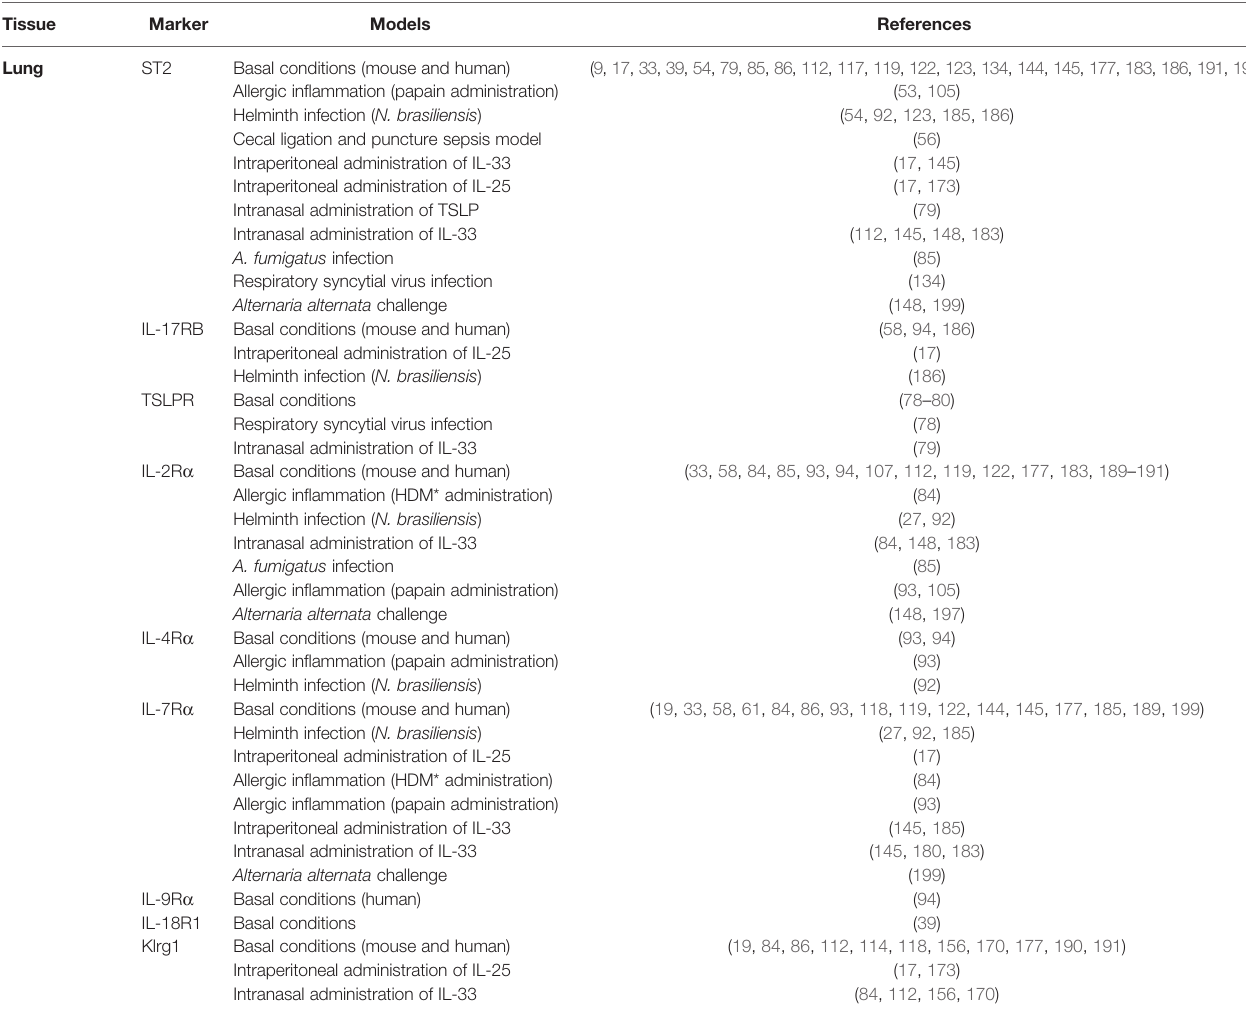
TABLE 1 | Expression of markers associated with the identi fi cation and regulation of ILC2s in different tissues and study models. Tissue Marker